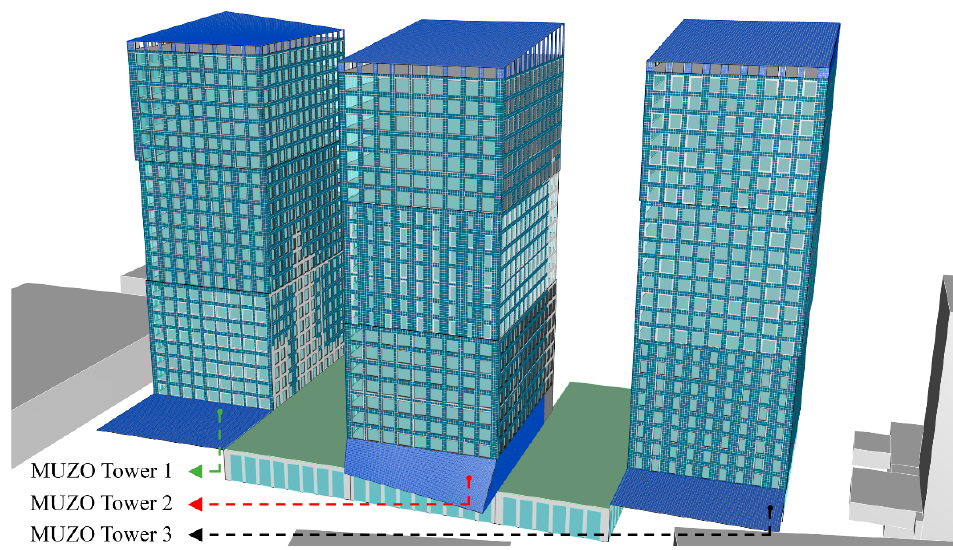
Figure 21. Illustration of the optimised design for self-sufficiency at the building scale.